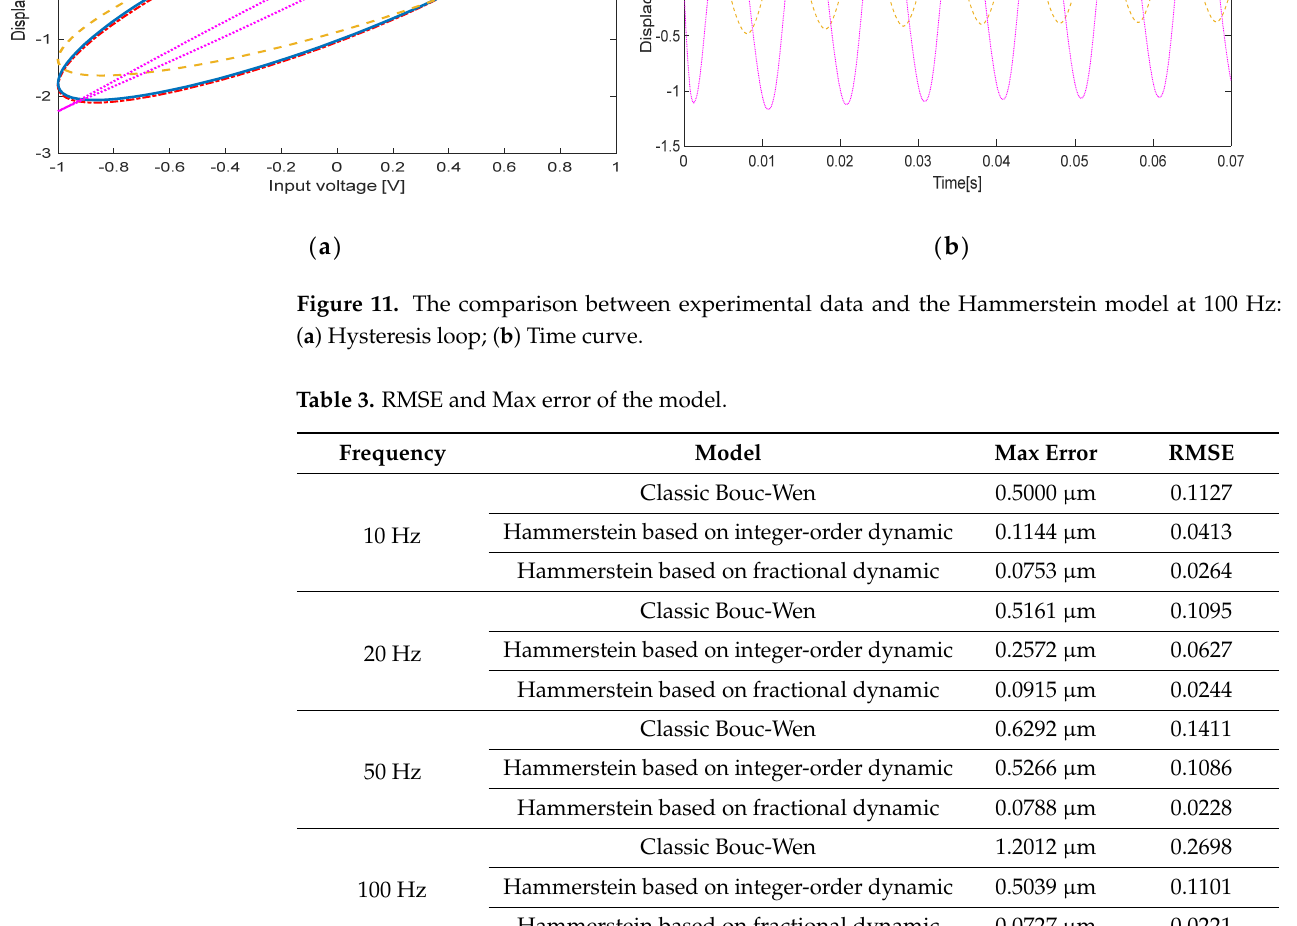
Table 3. RMSE and Max error of the model.